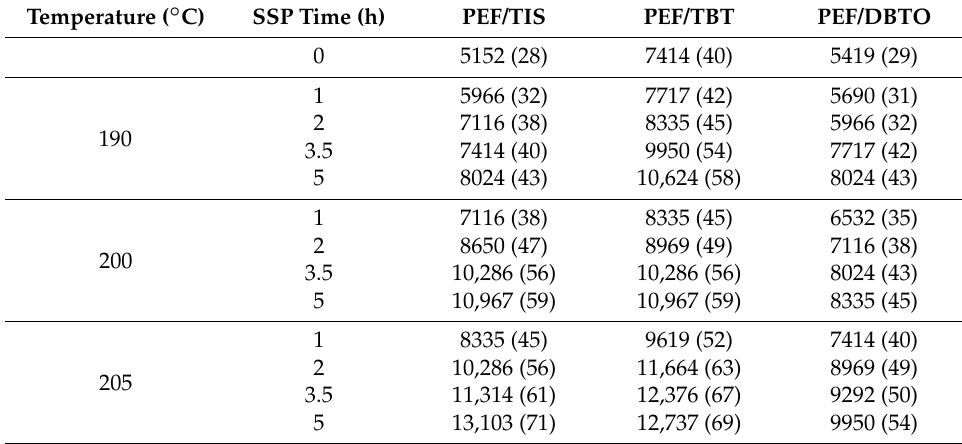
Figure 2. Variation of the intrinsic viscosity with time during solid-state polymerization (SSP) of PEF using different catalysts; TIS ( a ), TBT ( b ), and DBTO ( c ) at different temperatures. Continuous lines represent the theoretical kinetic model simulation results. Table 1. Numberaverage molecular weights ( M n , g/mol) of PEF polyester using different catalysts obtained after SSP at different temperatures and times. The value includes in parenthesis is the corresponding number average degree of